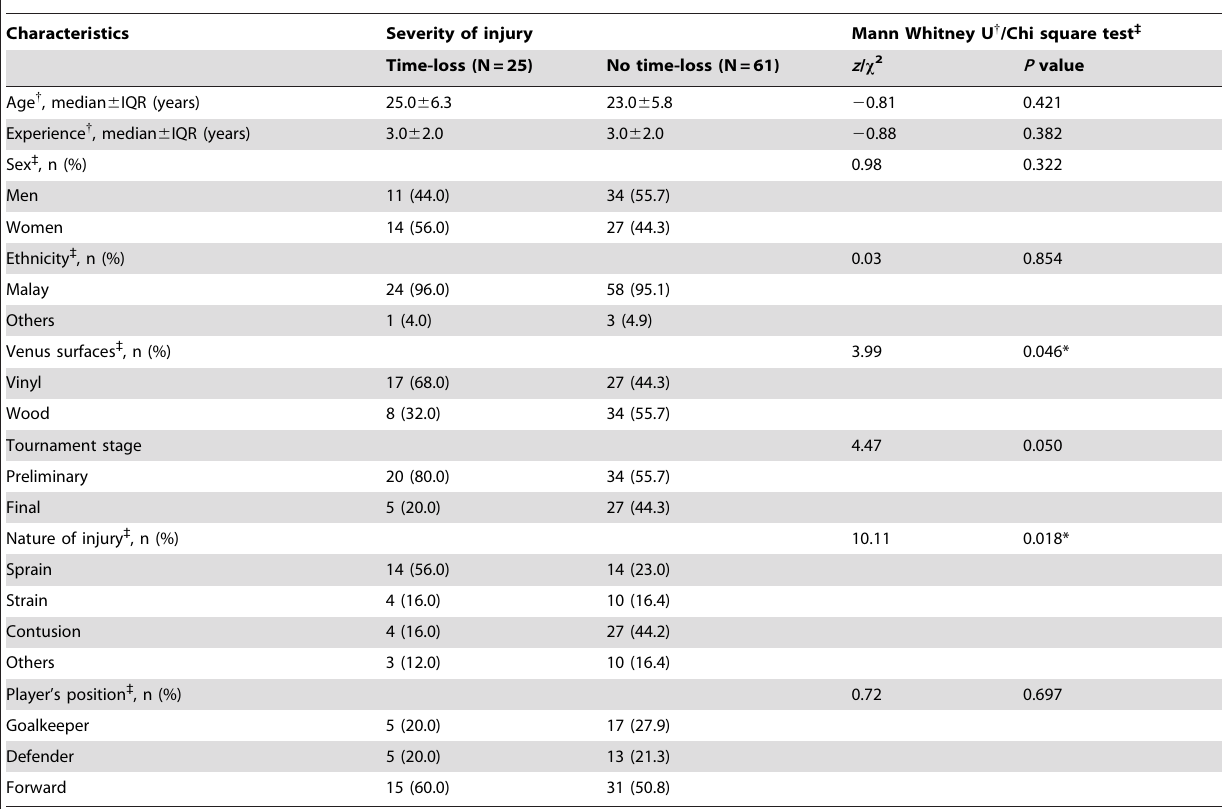
Table 5. Factors associated with injury severity during the 2010 FELDA/FAM National Futsal League.